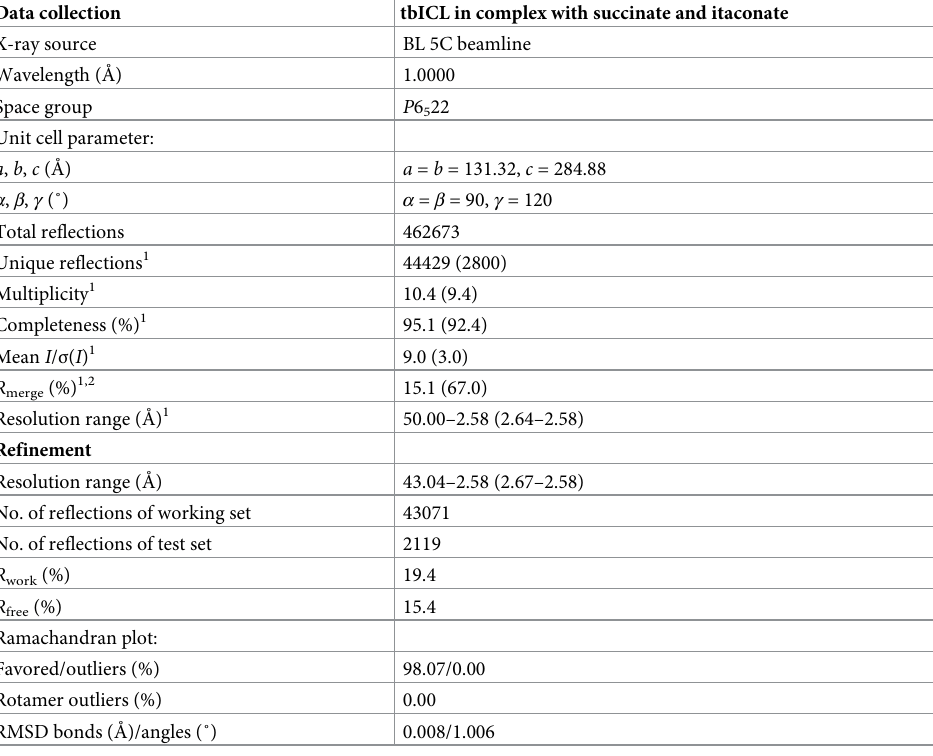
Table 1. Data collection and refinement statistics for tbICL in complex with succinate and